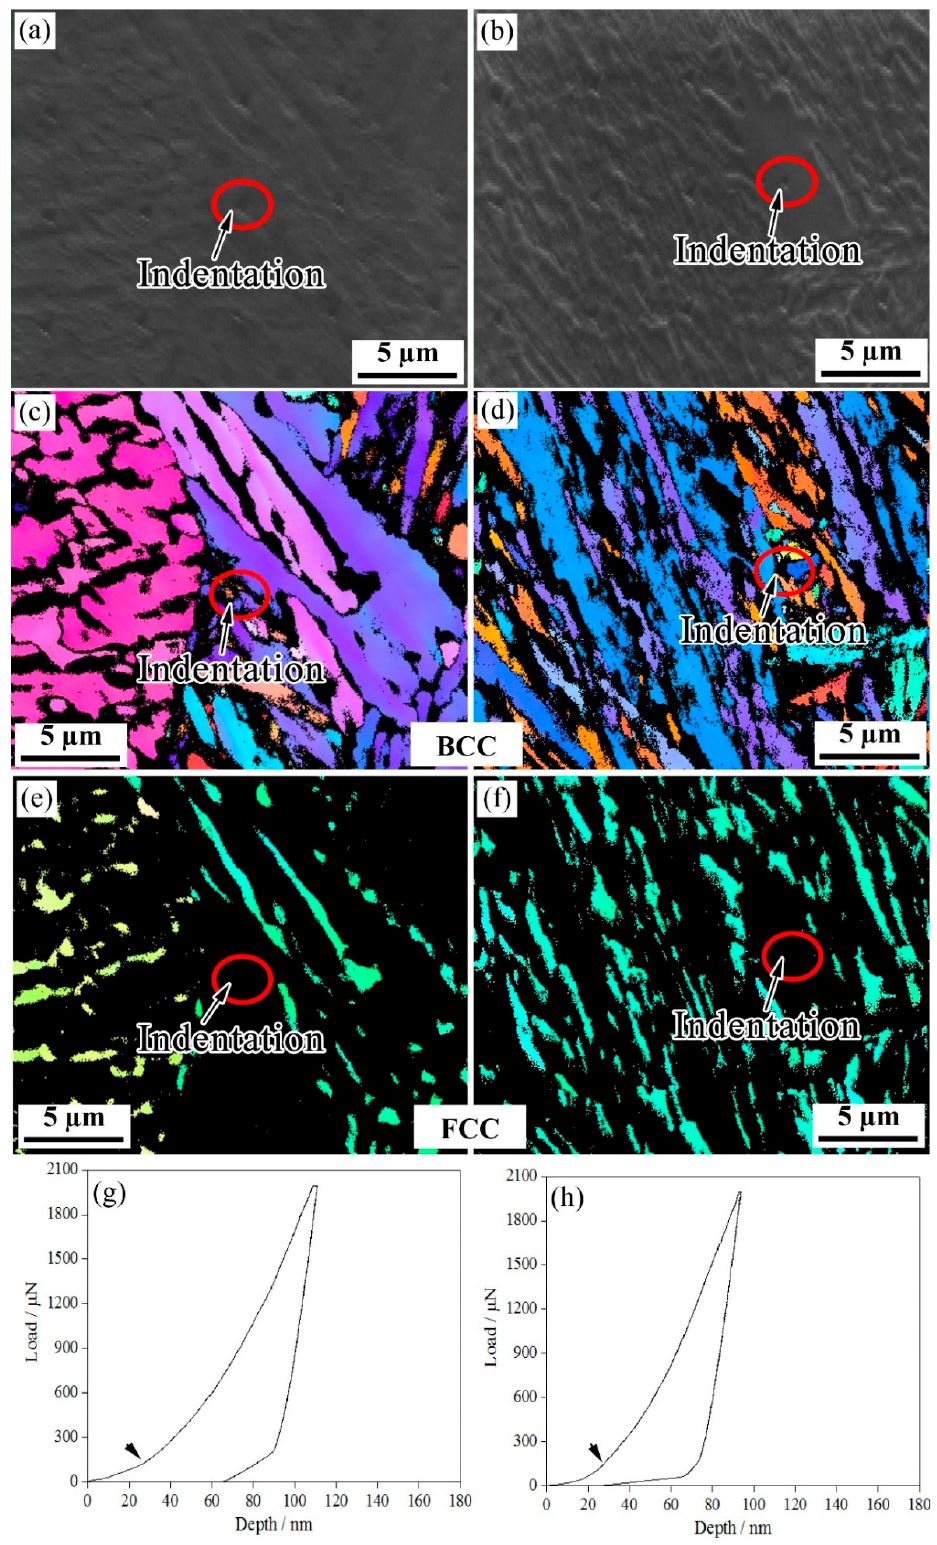
Figure 4. Nanoindentation of blocky M/RA in the investigated steel for ( a , c , e , g ) one-step and ( b , d , f , h ) two-step techniques. ( a , b ) SEM micrographs, ( c , d ) BCC structures, ( e , f ) FCC structures, and ( g , h ) representative load–displacement plots.